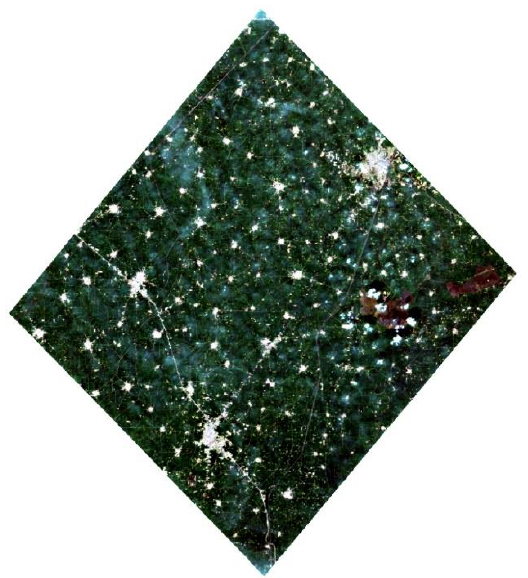
Figure 1: Rectified DESIS data of the study area (RGB bands: 94, 59, 28)